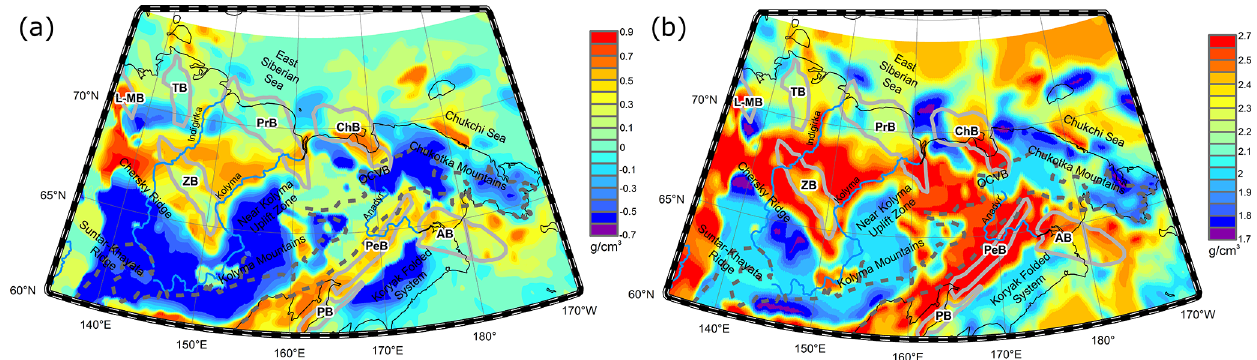
Figure 10. (a) Density correction. (b) Corrected density model (vertically averaged).